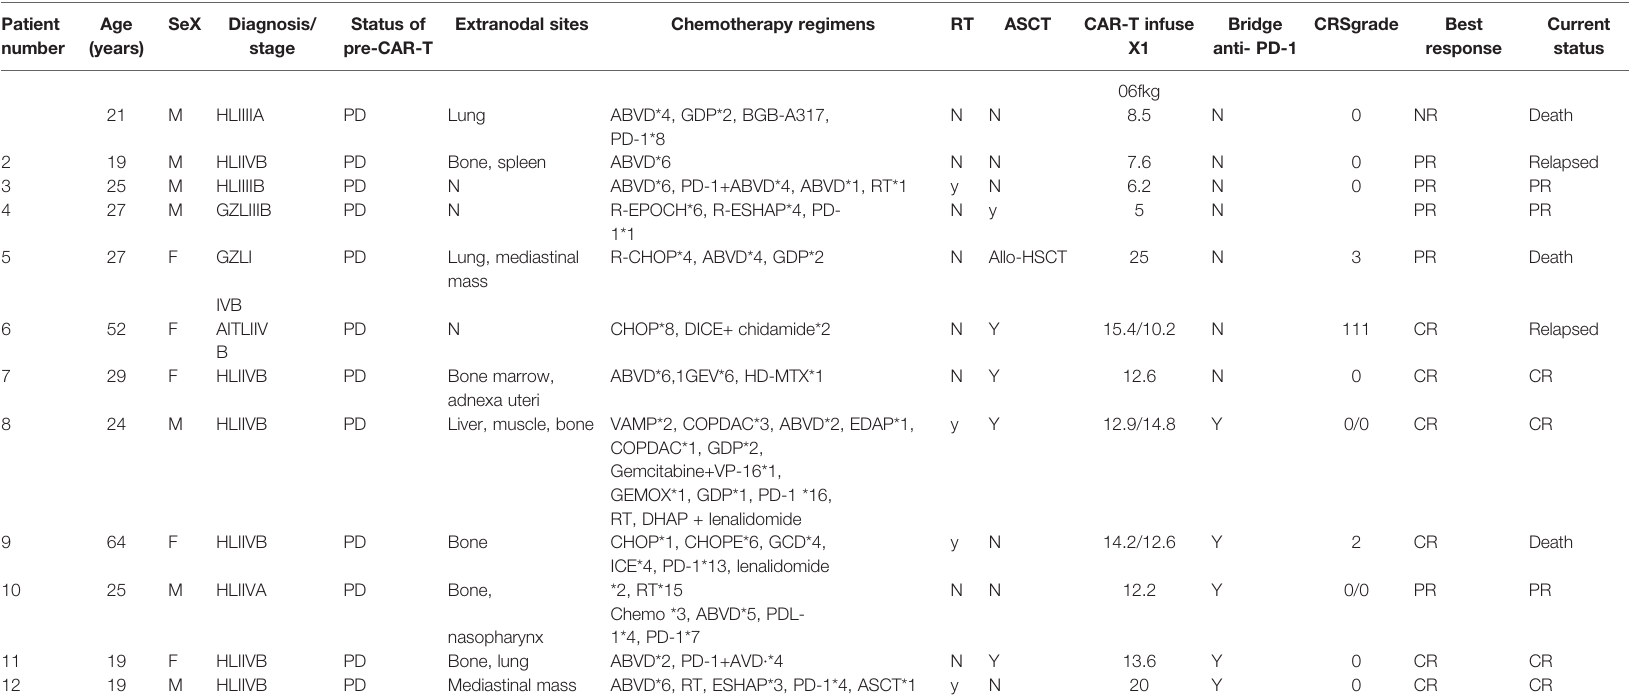
TABLE 1 | Baseline characteristics of